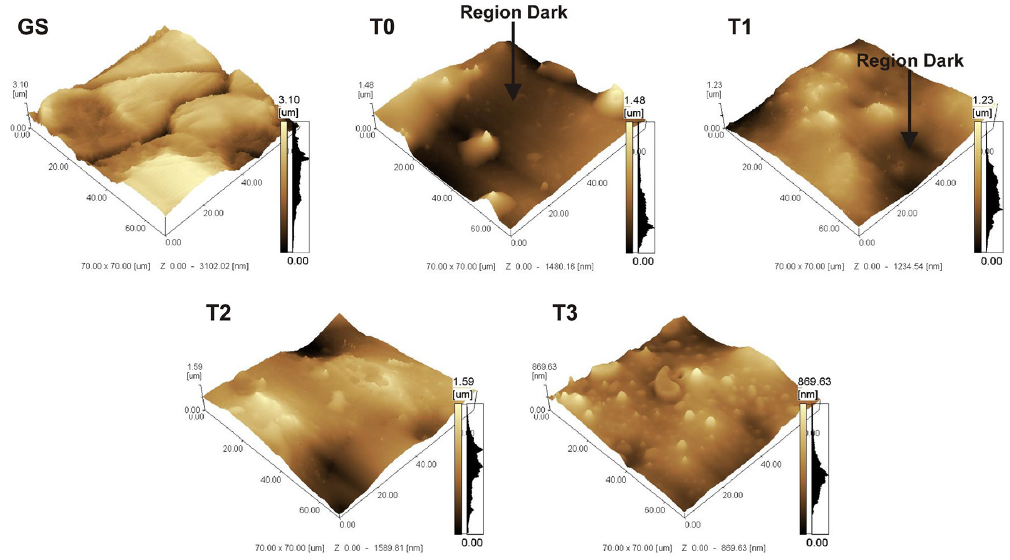
Figure 6. 3D AFM height of the systems. Table 2. Roughness of the obtained siloxane-PMMA hybrid coatings.